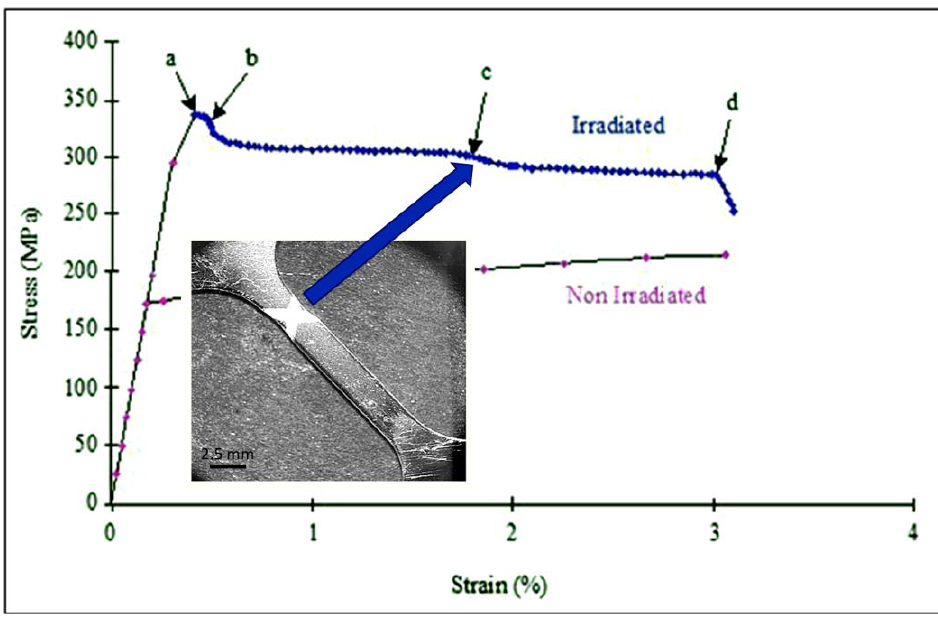
Figure 5. Engineering tensile stress–strain curve for a Zircaloy-2 sheet that had been irradiated at 300 °C to a neutron fluence of 1.1 × 1025 nm −2 and subsequently tested at 25 °C at a strain rate of 4.7 × 10 −6 s −1 . For description of points (a–d), see text. Modified from [17].